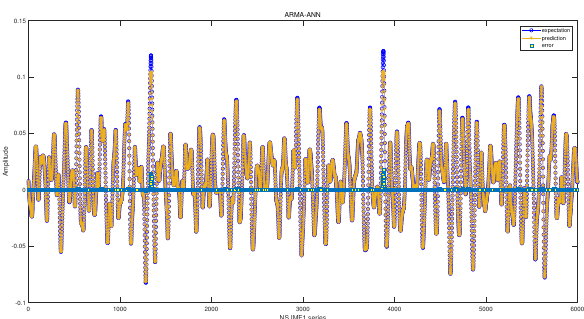
Figure 7. Prediction result of ARMA-ANN model for NS IMF1 time